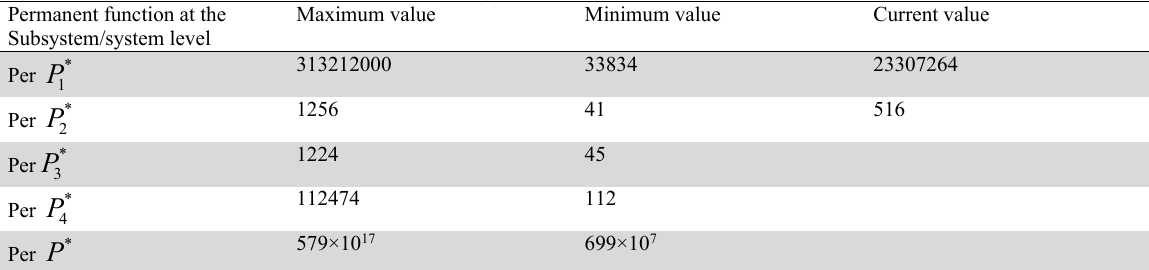
The maximum and minimum values of the permanent function Permanent function at the Maximum Subsystem/system level